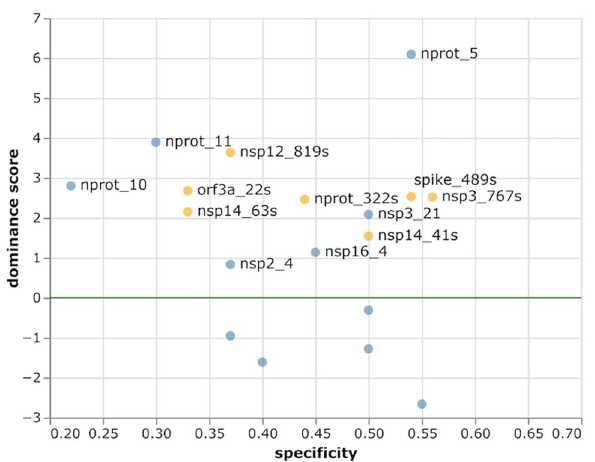
Figure 3. Dominance score vs specificity of predicted linear B-cell epitopes (blue) and structural epitopes (orange). Specificity is calculated as 1—conservation. The dominance threshold (DiscoTope2 minimal score scaled to 0) is shown as a green line. Potentially dominant epitopes are labelled. Scores below − 3 have been omitted for